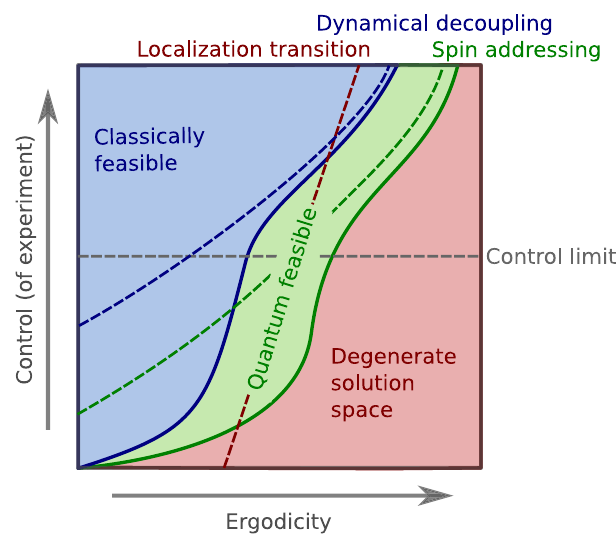
FIG. 1. Sketch of the “phases of learnability” of a quantum Hamiltonian. In the red region, the set of experimental data is insufficient to distinguish candidate Hamiltonians. This becomes increasingly likely for systems beyond a localization transition (red dashed line), as after this point experiments such as local correlators tend to provide little information about the system structure. In the blue region, the experimental data is sufficient to learn the system’s structure, but the data processing may be achieved classically, rendering a quantum computer unnecessary. This classical processing may either be achieved by the system being well approximated by a classically computable model, or by the experiment having sufficient control (gray dashed line) to isolate smaller subsystems. At the limit of good control, an experiment has the ability to dynamically decouple individual terms (blue dashed line), after which techniques such as those in Refs. [46,48] can be used to estimate terms individually. A simpler limit is to simply have the ability to address individual (or small frequency regions of) spins in the system (green dashed line), which renders the system more